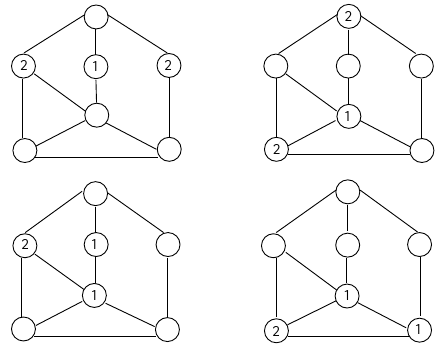
Figure 1: Four minimum antiregular dominating sets in a graph G .